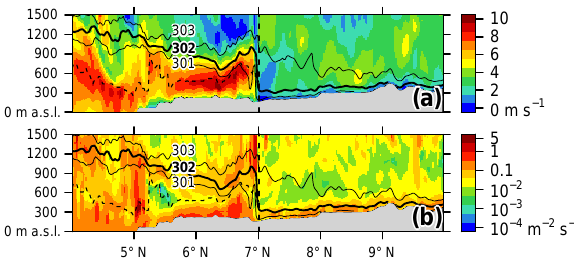
Figure 8. Meridional–vertical transects (ma.s.l.) of (a) wind speed (shading, ms − 1 ) and (b) turbulent kinetic energy (TKE; m − 2 s − 2 in logarithmic scale) along 5.75 ◦ W (central Ivory Coast) for 2 July 21:00UTC with respect to the reference case. The solid black con- tours show the potential temperature for 301, 302 and 303K, while the bold isentrope (302K) is used for the identification of the AI front (vertical dashed line). The horizontal dashed line shows the NLLJ wind speed maximum (jet axis) in the AI postfrontal area. The gray shading indicates the